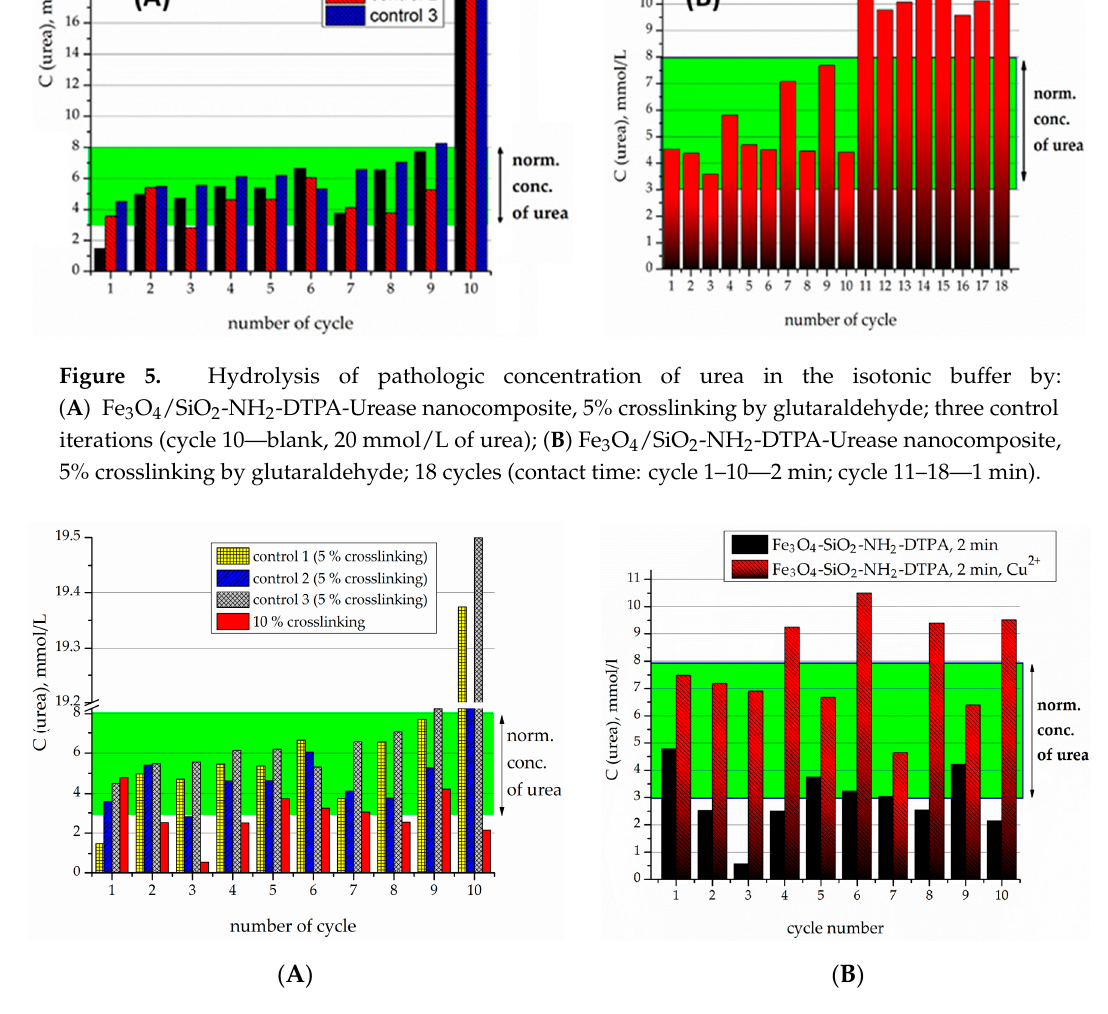
Figure 7. Residual activity of crosslinked urease on the surface of Fe 3 O 4 /SiO 2 -NH 2 -DTPA nanoadsorbents in presence of copper (II) and cadmium (II) ions.